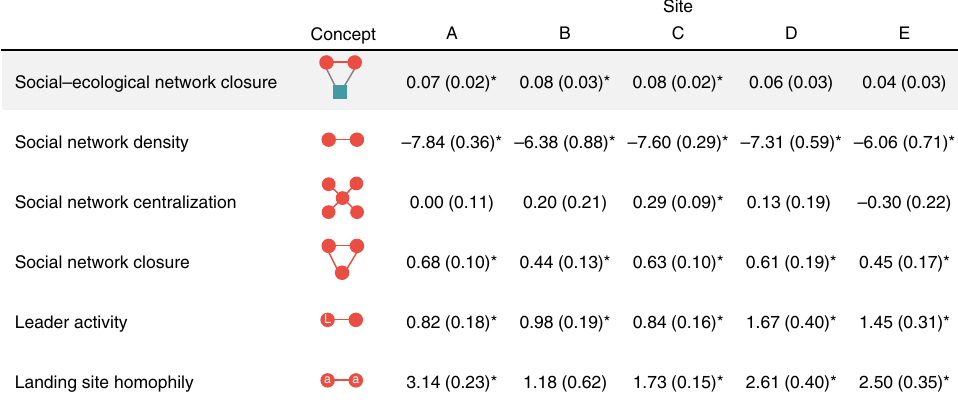
Fig. 3 The importance of social – ecological network closure. Values shown are the coef fi cients (and SEs) of social – ecological network closure (shaded) and other key parameters from fi ve multilevel exponential random graph models (ERGMs) fi t to empirical social – ecological networks representing each of the fi ve reef fi shing communities studied (sites A – E). Shapes and colors in the conceptual graphical depictions follow Fig. 1. L indicates an actor in the social network who is also a leader, and the tie linking this leader to another social actor demonstrates the potential for leaders to have more ties on average than others; a indicates an actor in the social network who uses hypothetical landing site a , and the tie linking this actor to another whom also uses landing site a demonstrates the potential homophily effect on landing site. Note that the depictions for centralization and closure in the social network are only representative and do not explicitly capture the alternating nature of the speci fi c parameters included in the model (termed ASA and ATA in MPNet; Methods, Supplementary Methods). Full models also included controls for activity in each landing site where a residual analysis suggested that fi shers may be more active in forming and maintaining ties than would be expected by chance alone (Supplementary Table 5). Asterisk (*) indicates signi fi cance at P